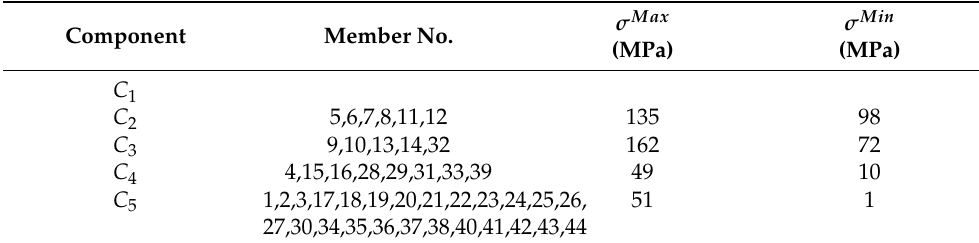
Table 5. The optimized design for Model 2.